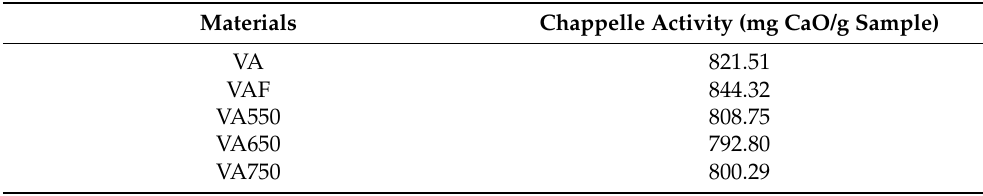
Table 3. Chappelle test results of VA, VAF, and heat-treated VA550, VA650, and VA750 according to NF P